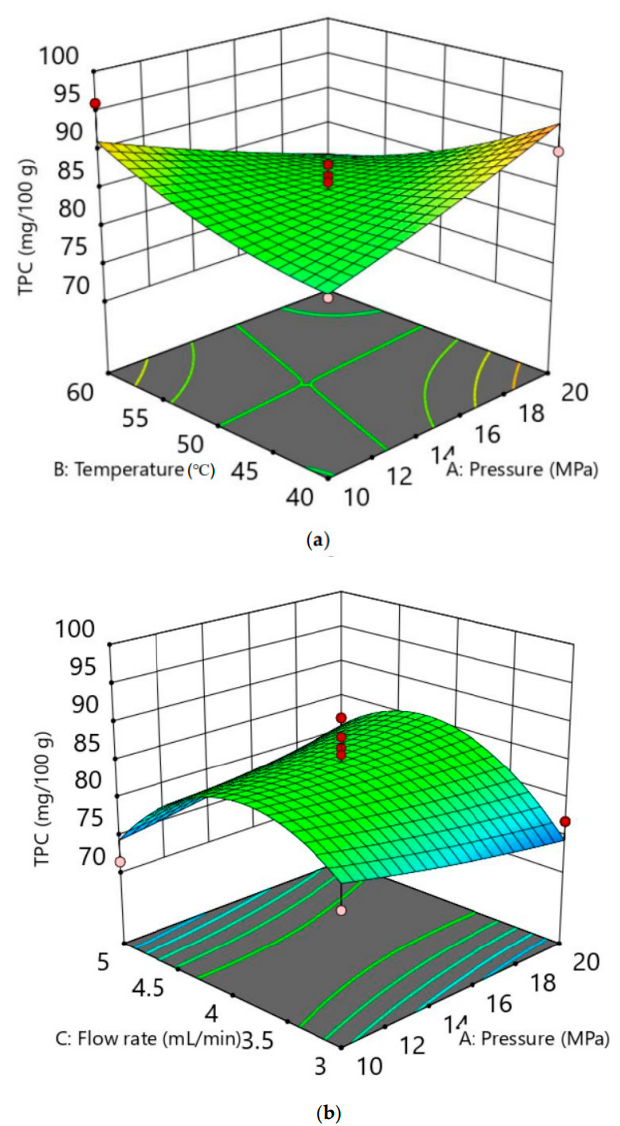
Figure 3. The effect of ScCO 2 ′ s variables on TPC, mg/100 g, ( a ) effect of pressure and temperature at constant flow rate; ( b ) effect of pressure and flow rate at constant temperature.